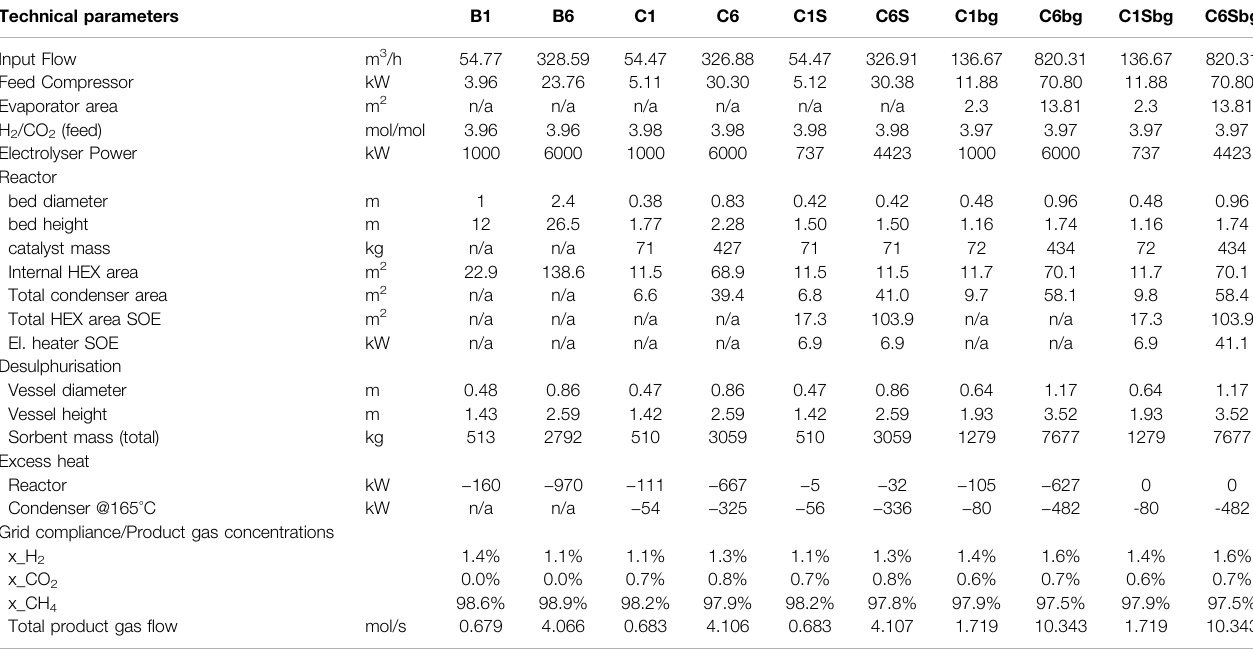
TABLE 4 | Technical data for the considered processes. The processes marked with “ bg ” are operated using biogas as feed. Technical